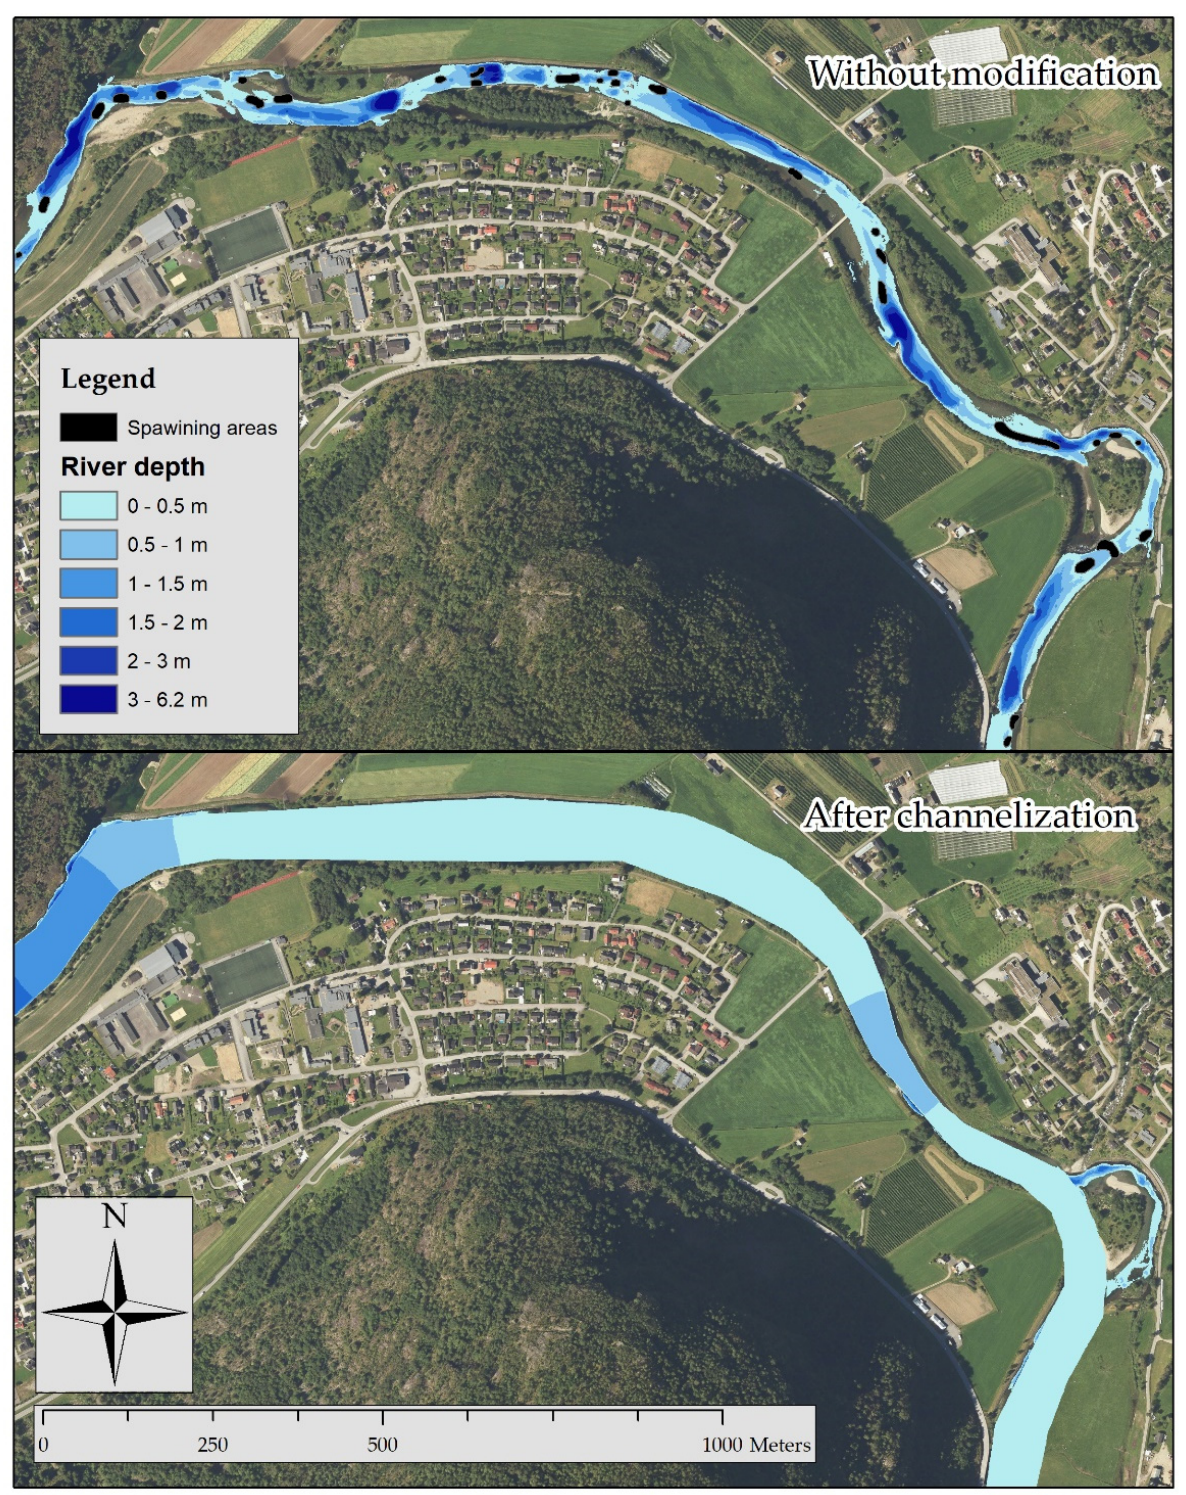
Figure 8. Map of river depths without river modification (top) and after channelization (bottom) at 10 m 3 /s.